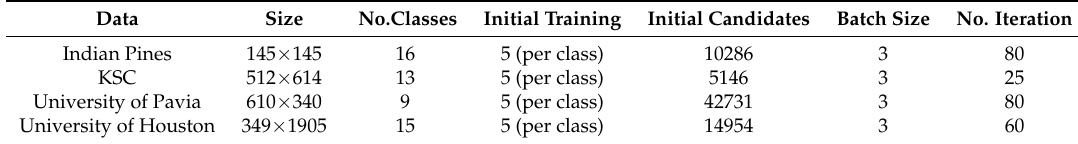
Table 2. Experimental settings of the four hyperspectral